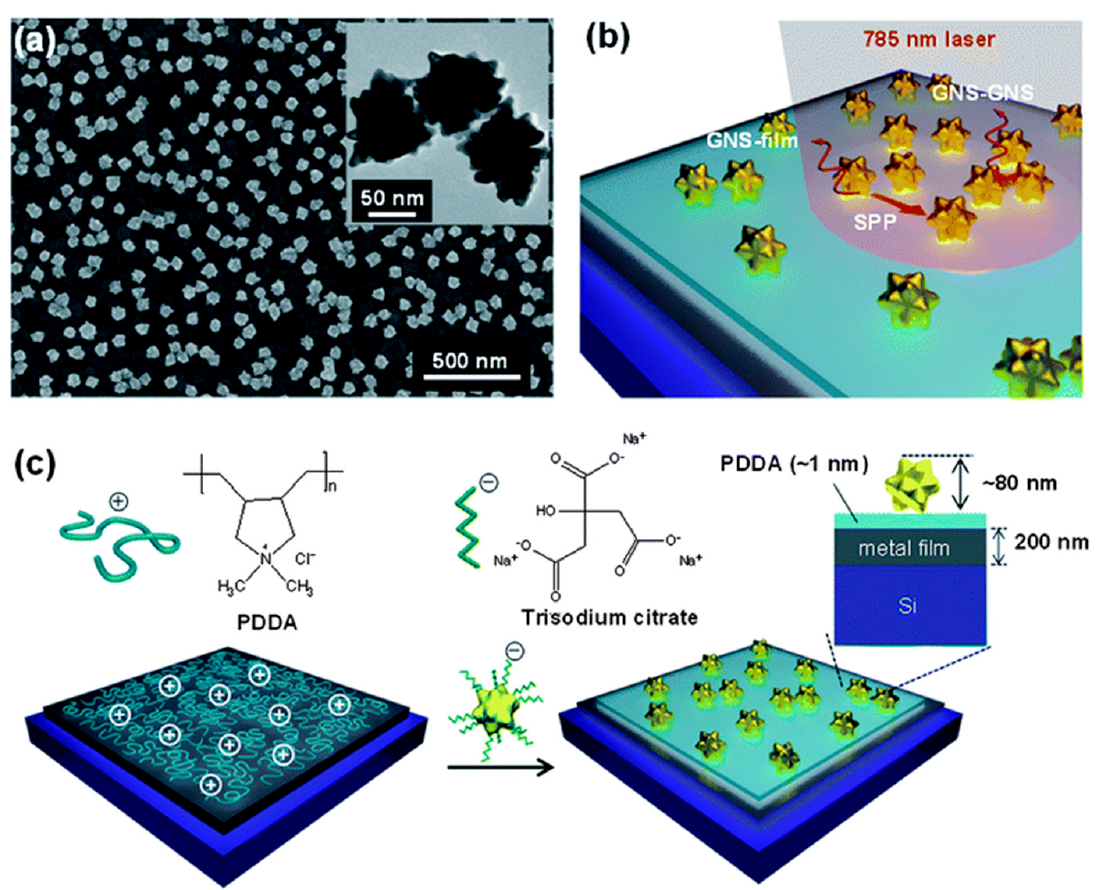
Figure 3. Formation of high-density nanostar (NS) assemblies on metal films. ( a ) An SEM image of high-density NS assemblies on a metal film. The inset shows a TEM image of NSs with sharp tips. ( b ) Schematic representation of field enhancements on the high-density NS assemblies on a metal film showing the NSs-film and NSs-NSs plasmon couplings, in combination with the propagating SPP (surface plasmon polaritons) modes on the metal film. ( c ) Schematic procedure of the electro- static assembly of high-density NSs on metal films via the electrostatic interaction between nega- tively charged sodium citrate additives on the NS assemblies and the positively charged PDDA